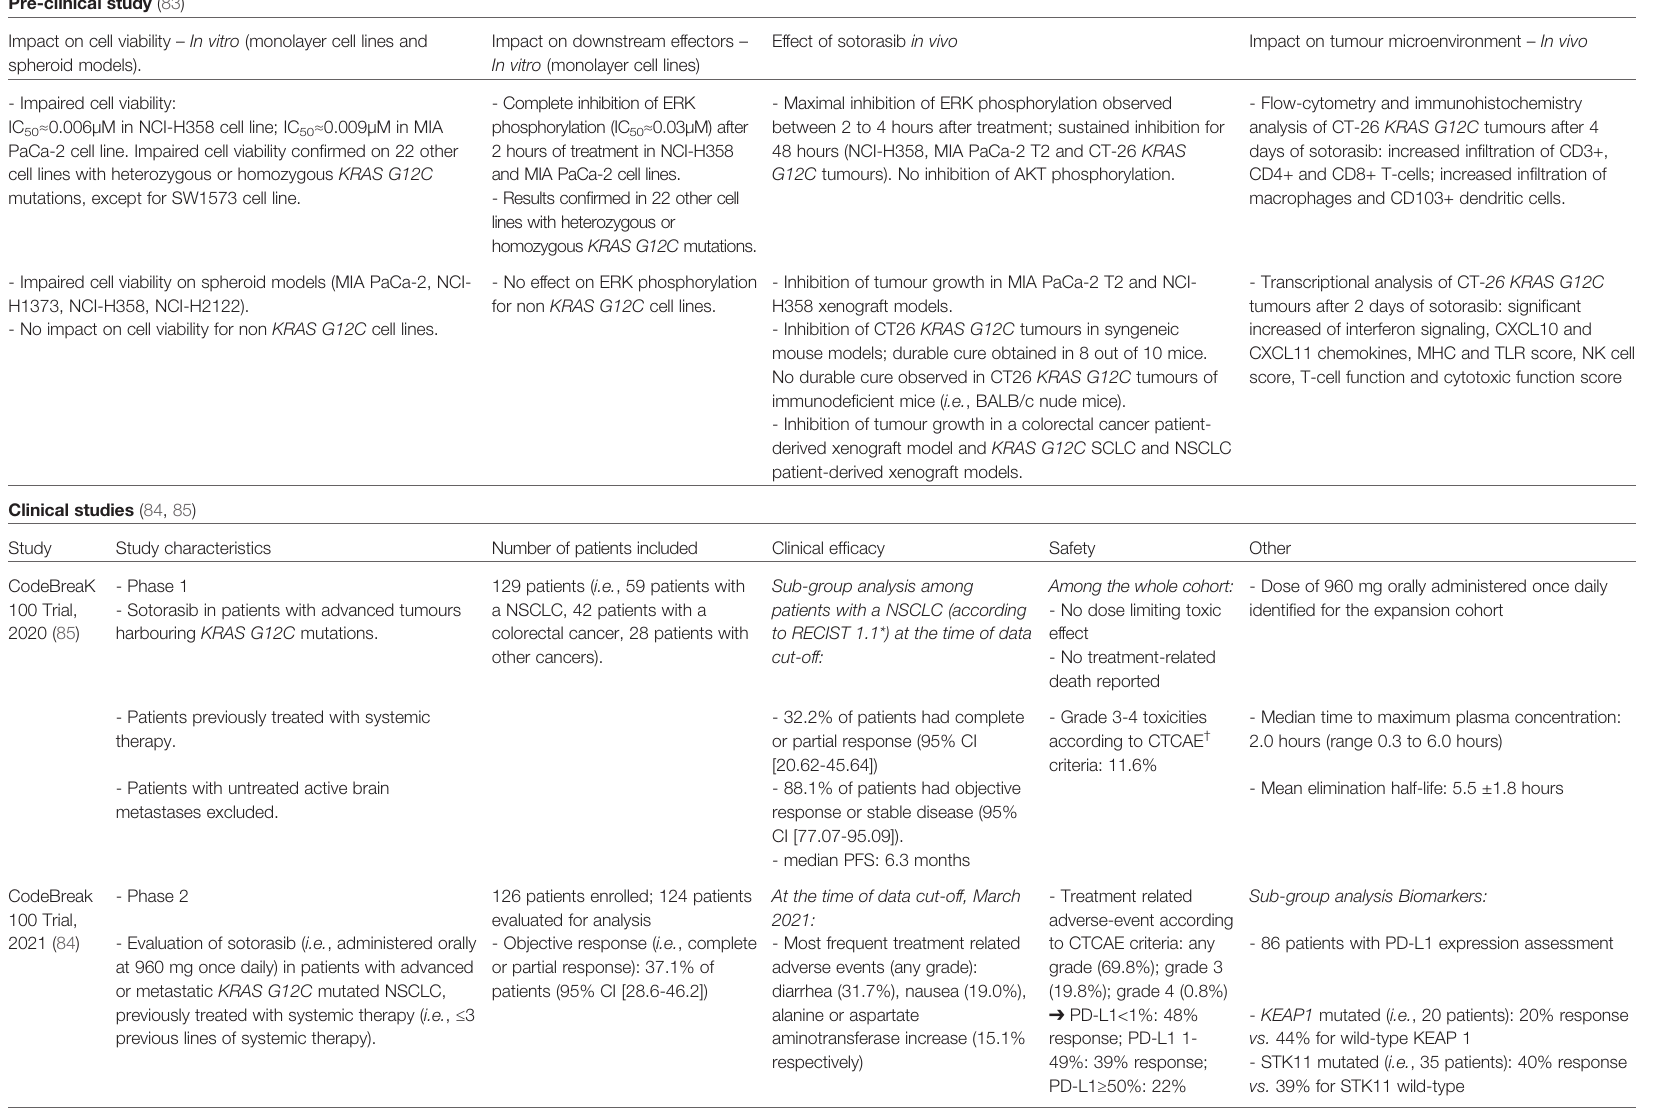
TABLE 1 | Sotorasib: synthesis of pre-clinical and clinical development. Pre-clinical study